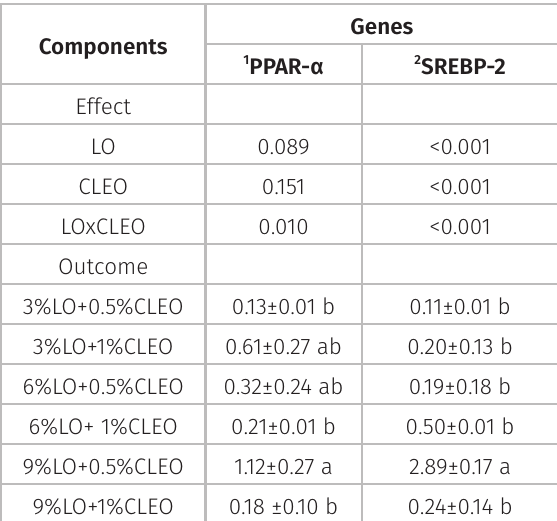
Table VII. Expression of the PPAR-α and SREBP-2 genes assessed in zebrafish ( Danio rerio ) fed experimental diets containing linseed oil (LO) and clove leaf essential oil